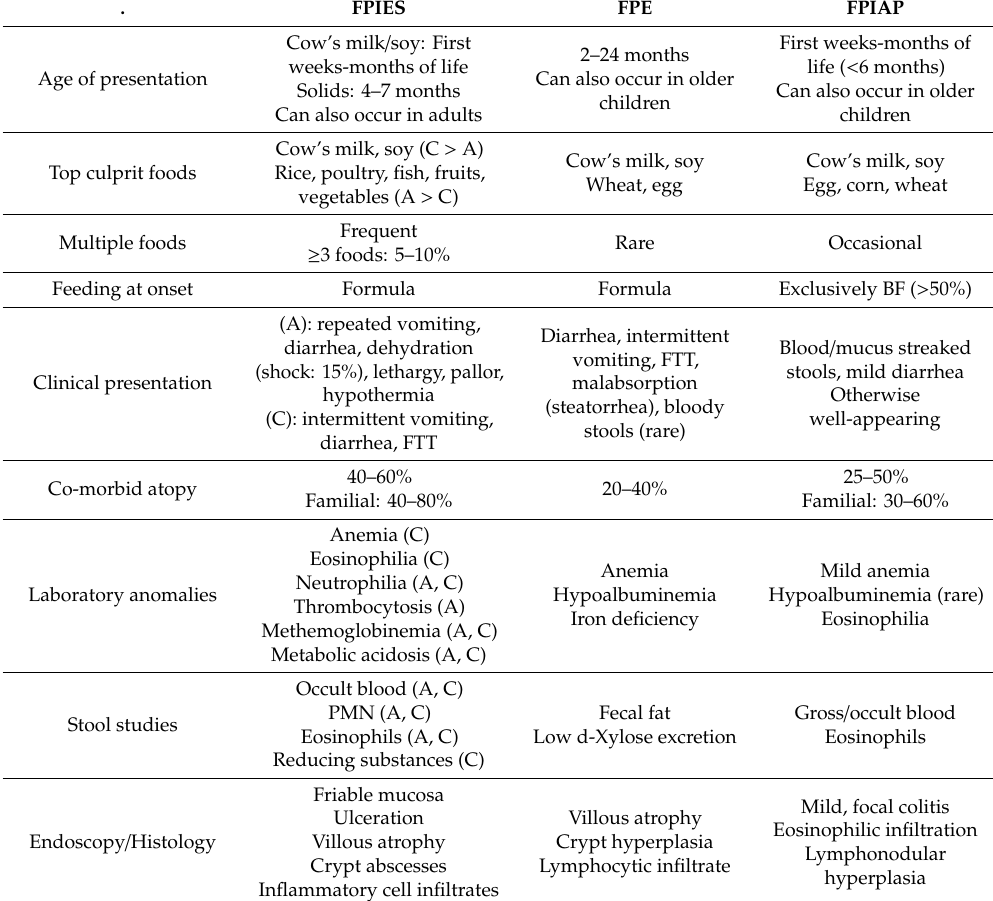
Table 1. Clinical and laboratory features of non-IgE-mediated gastrointestinal food allergies. . FPIES FPE